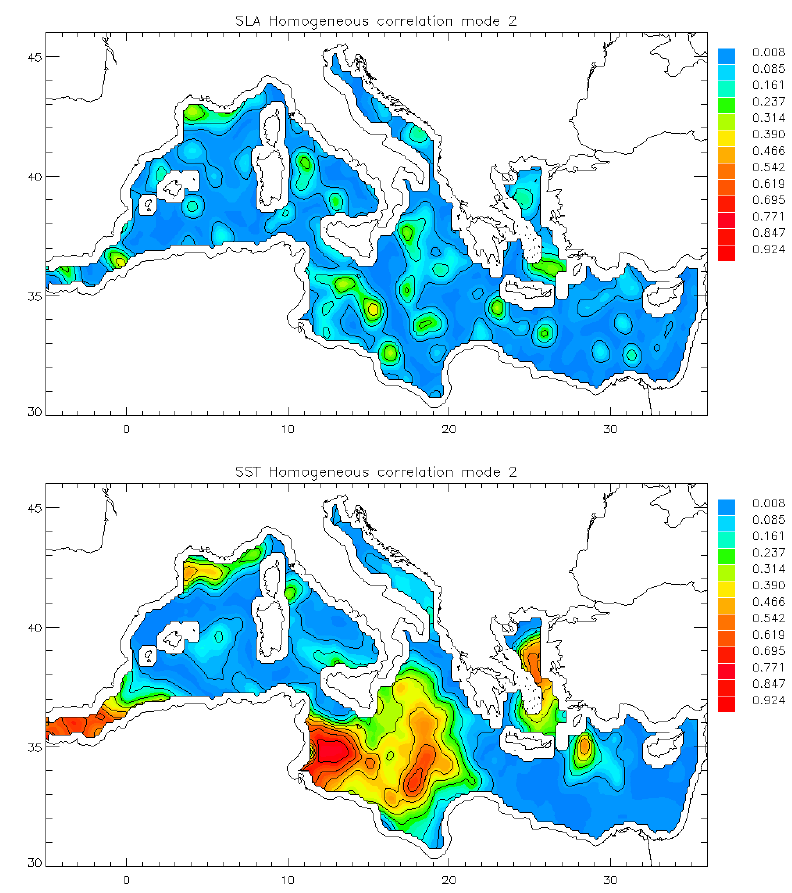
Fig. 8. SLA (a) and SSTA (b) homogeneous correlation maps relative to the second “gradient CPA”